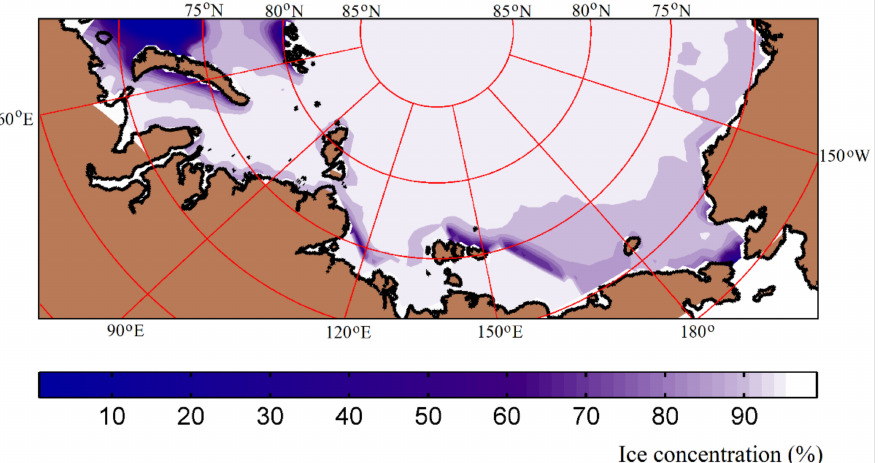
Figure 3. Simulated sea ice concentration in May 2014. Area of reduced ice concentration in the Laptev and East-Siberian seas shows fast ice